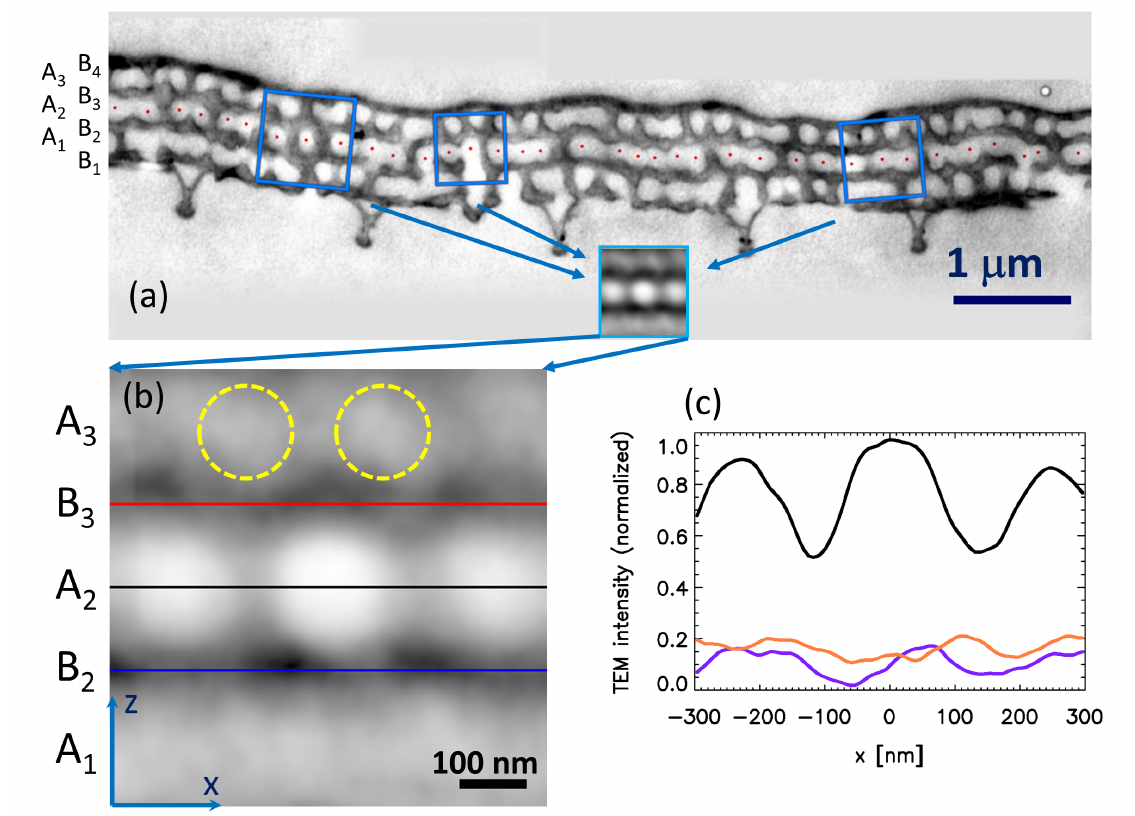
Figure 2. Direct space averaging applied to a TEM micrograph. ( a ) Cross-sectional TEM image of a ventral cover scale of Albulina metallica with four chitin layers (“B” layers) and three perforated chitin layers containing spherical air voids (“A” layers). The scale is shown facing down to illustrate that this is a ventral scale. The red dots show the centers of the air voids in the middle perforated layer ( A 2 ). The three blue squares illustrate the averaging process for three selected air voids, but in the real calculation, the averaging was done for all of the air voids (see the text for details). The inset shows the calculated averaged image. ( b ) DSA processed image of the TEM micrograph shown in (a) (same as the inset in (a), but enlarged). The horizontal lines show the positions where linecuts were calculated (in the B 2 and B 3 layers). The yellow dashed circles show the positions of the intensity maxima in the A 3 layer. x ( z ) is the horizontal (vertical) direction, respectively. ( c ) Linecuts from the DSA image in (b). The black line shows the grayscale intensity of image (b) along the middle perforated layer ( A 2 layer), and the red and blue lines show the intensity along the two adjacent chitin layers ( B 2 and B 3 layers). The intensity value is scaled into the [0,1] interval, and zero means the minimum intensity, one the maximum intensity (see the text for